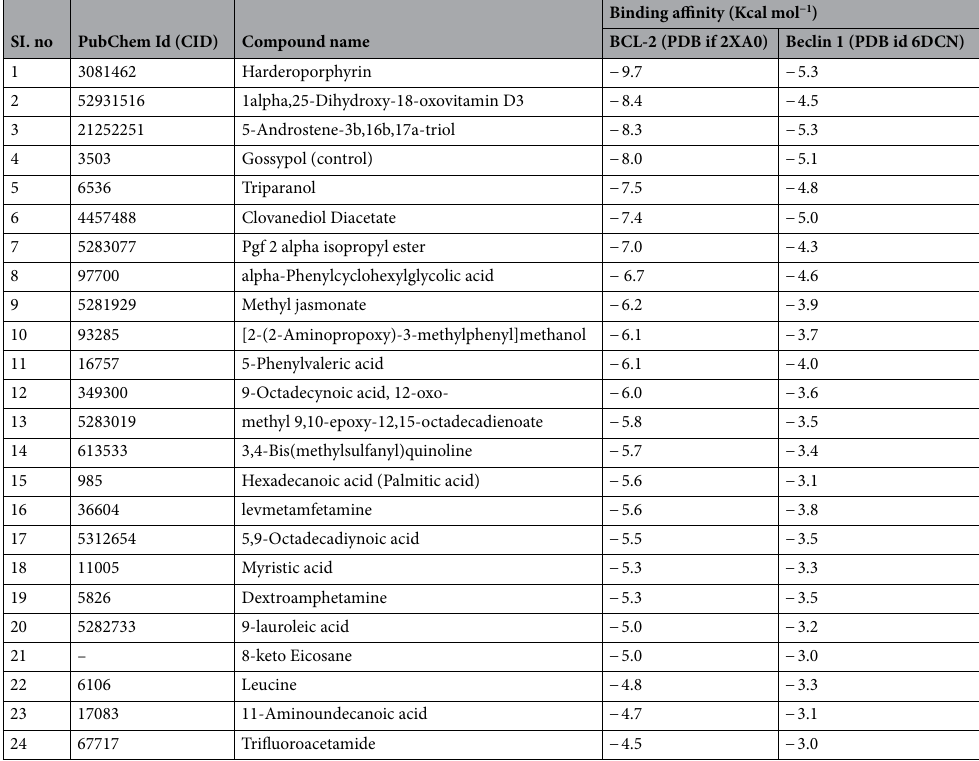
Table 1. Binding affinities of the phytochemicals present in CCF with Bcl2- and